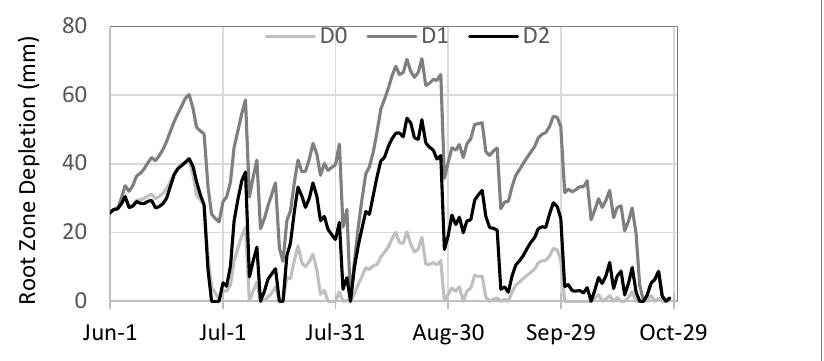
Figure 2. Root zone depletion model applied to irrigated treatments with water (D0) or leachate (D1, D2) in 2020.